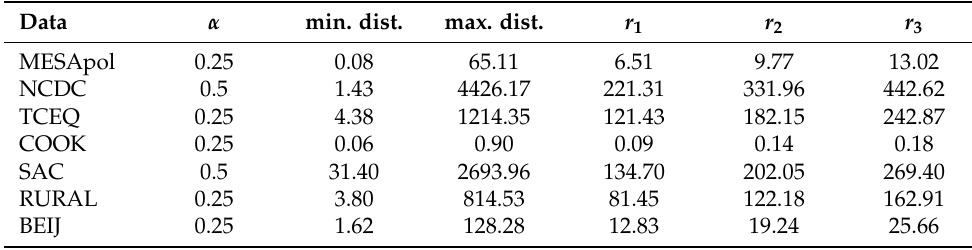
Table 3. Parameter α and distances between stations (in kilometres) and spatial radius of each spatiotemporal neighbourhood when temporal distance is zero ( d T = 0), r i = β i / α , β ∈ { 0.0250, 0.0375, 0.0500 }